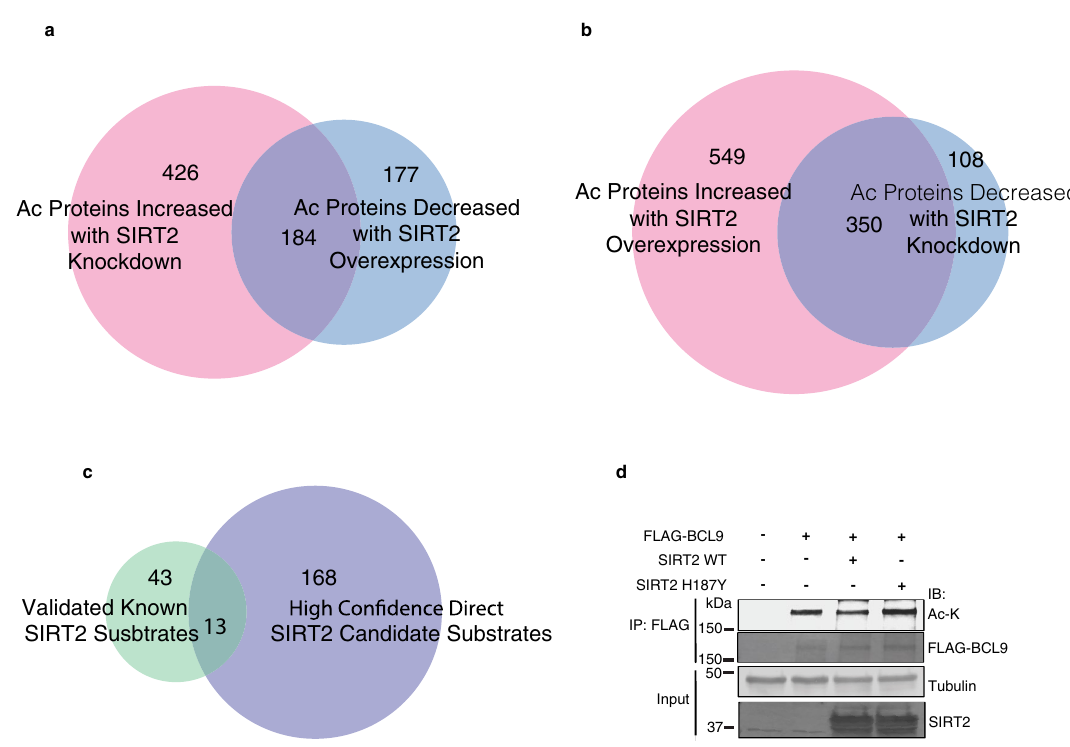
Figure 2. Venn diagrams of acetylated lysine proteins reveal direct and indirect SIRT2 targets. ( a ) Acetyl- lysine proteins upregulated 1.5 fold following SIRT2 knockdown and downregulated 1.5 fold following SIRT2 overexpression. ( b ) Acetyl-lysine proteins upregulated 1.5 fold following SIRT2 overexpression and downregulated 1.5 fold following SIRT2 knockdown. ( c ) Venn diagram of validated known SIRT2 substrates with high confidence direct SIRT2 substrates discovered in the present study. Same proteins with multiple gene symbols are consolidated into one. ( d ) 293 cells were transfected with FLAG-BCL9 together with histone acetyltransferases, and wild-type FLAG-SIRT2 or deacetylase-inactive FLAG-SIRT2 H187Y in the presence of TSA, immunoprecipitated with anti-FLAG agarose beads, separated by SDS-PAGE, and immunoblotted with antibodies against FLAG, acetyl-lysine, and